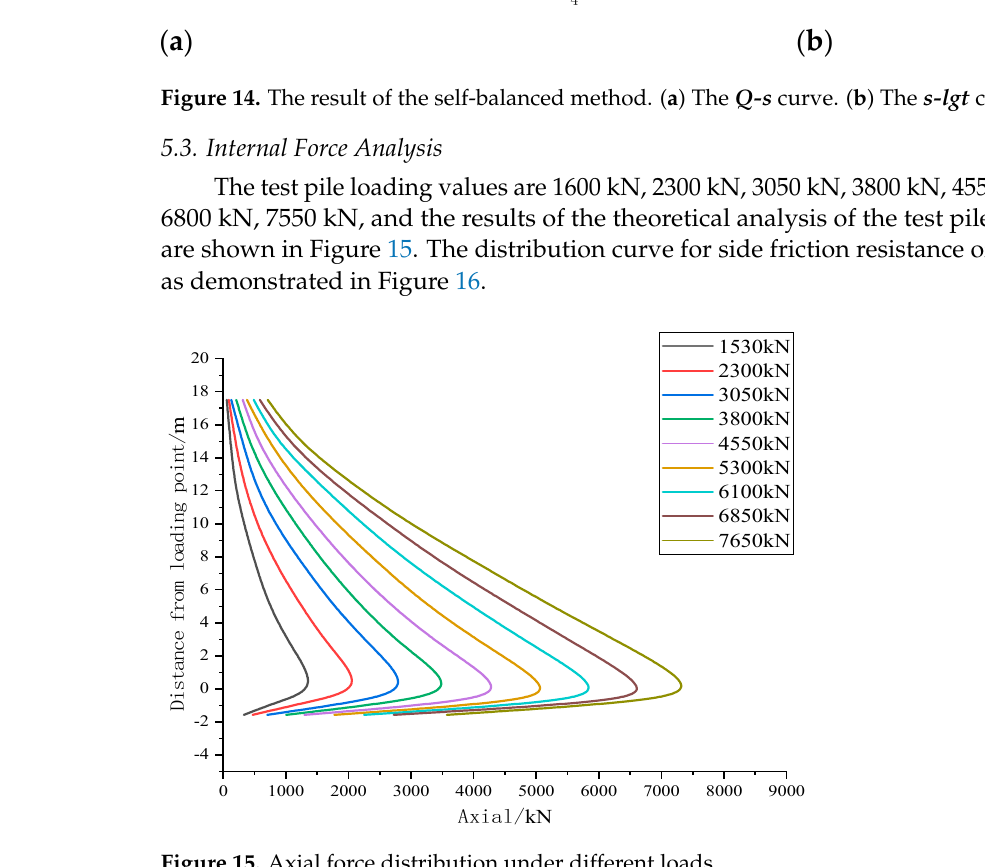
Figure 14. The result of the self-balanced method. ( a ) The Q-s curve. ( b ) The s-lgt curve.